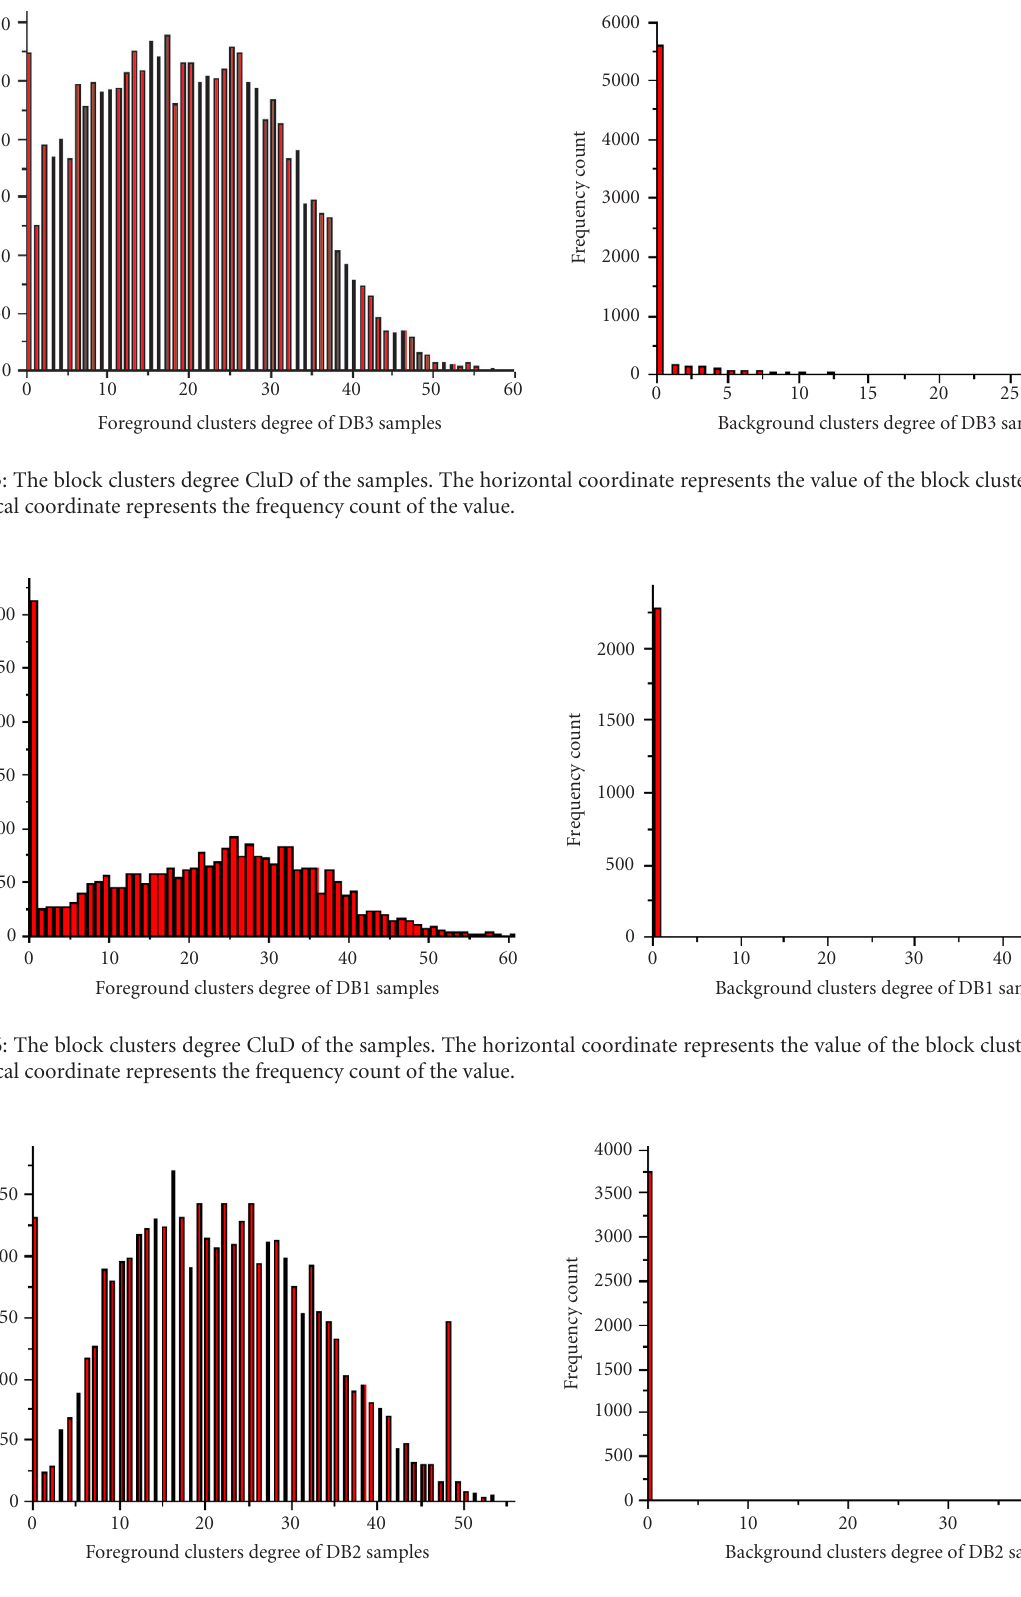
Figure 7: The block clusters degree CluD of the samples. The horizontal coordinate represents the value of the block clusters degree while the vertical coordinate represents the frequency count of the